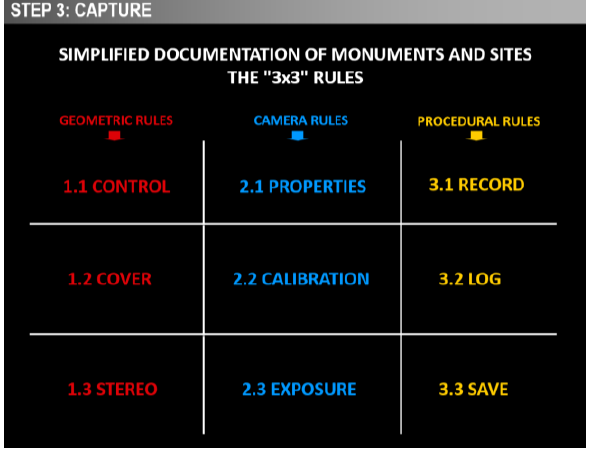
Figure 7. Simplified CIPA 3x3 rules (authors, 2012)